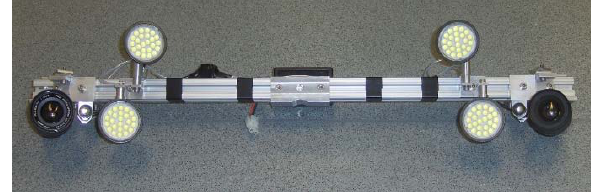
Figure 3. Top view of the camera rig, showing camera lenses, positioning lasers and LED lights.